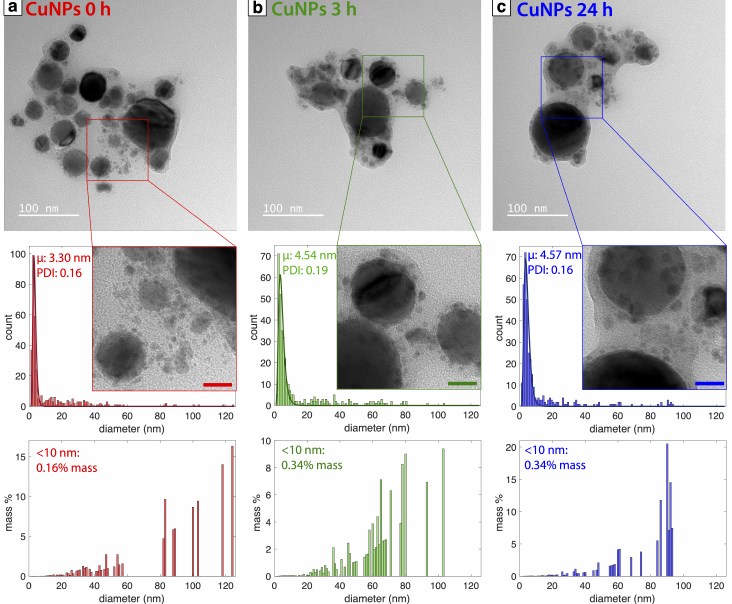
Figure 1. TEM images and corresponding number-weighted and mass-weighted size distributions for samples analyzed ( a ) 0 h, ( b ) 3 h, and ( c ) 24 h after synthesis. Scale bars in magnified regions are 20